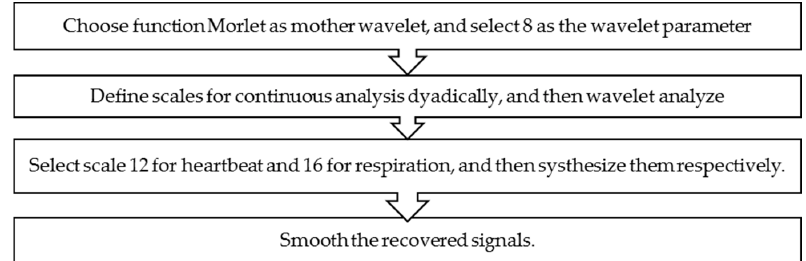
Figure 6. Flowchart of the separation method using the Morlet CWT.